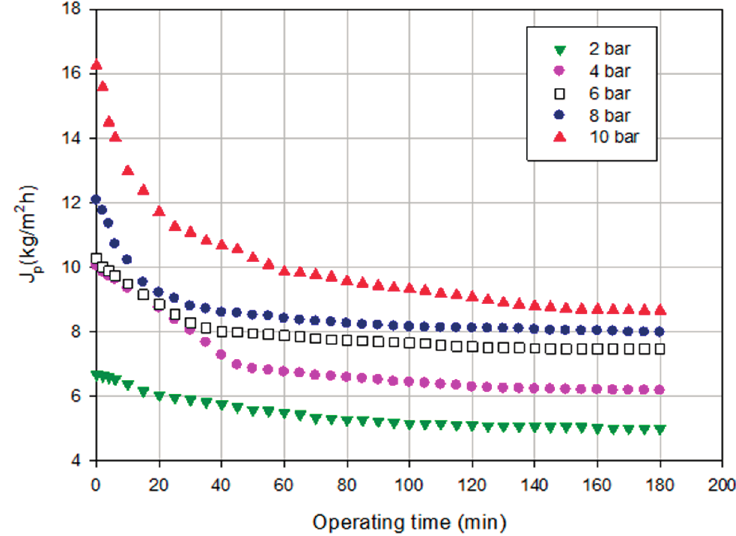
Figure 3. Time course of permeate flux at different TMP values (NP030 membrane, total recycle configuration, 25 °C).